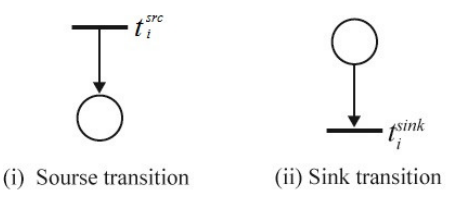
Figure 2. Source and sink transitions.